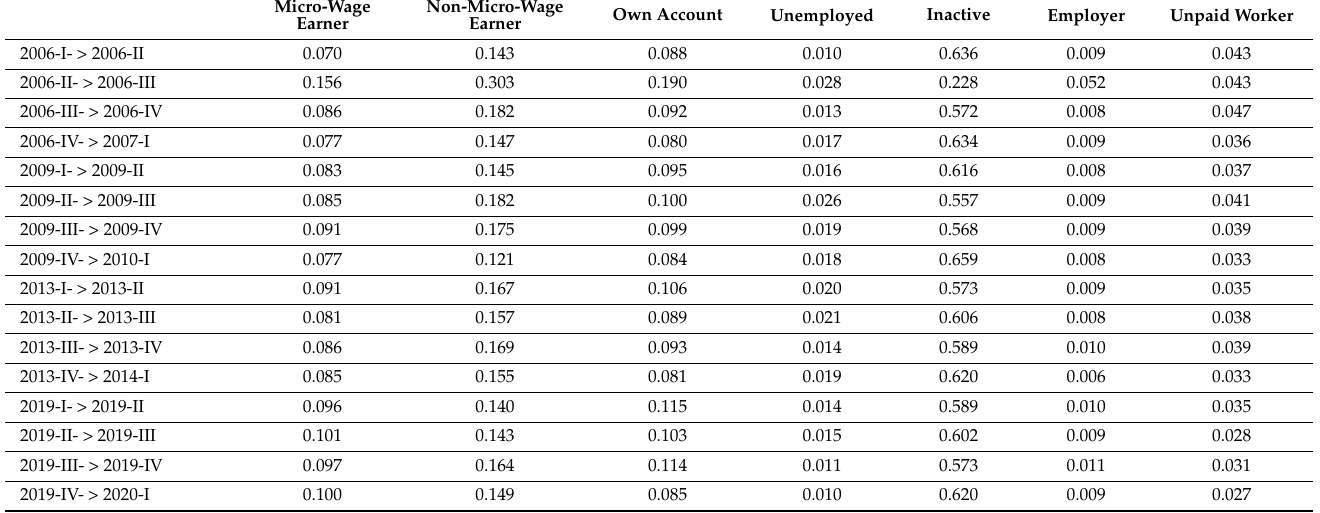
Table 6. Employment-transition steady states of women in Mexico.